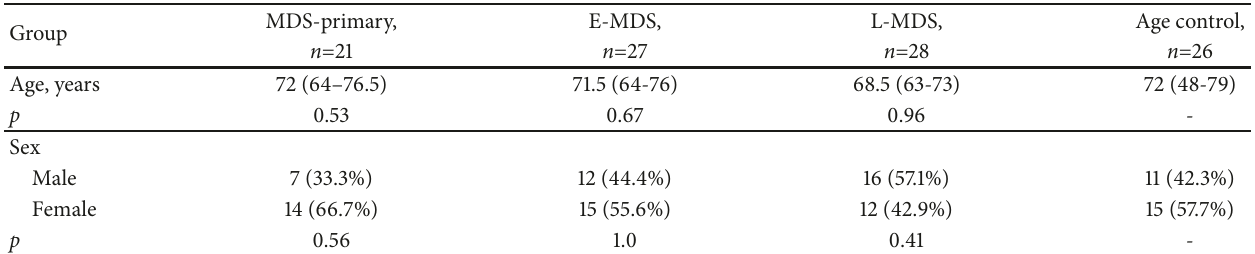
Table 1: Groups of patients with